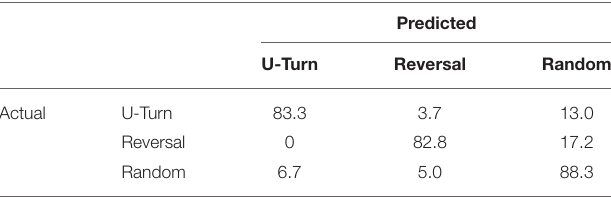
TABLE 2 | Normalized confusion matrix showing the percentage of actual and predicted classes for 3 different behaviors.